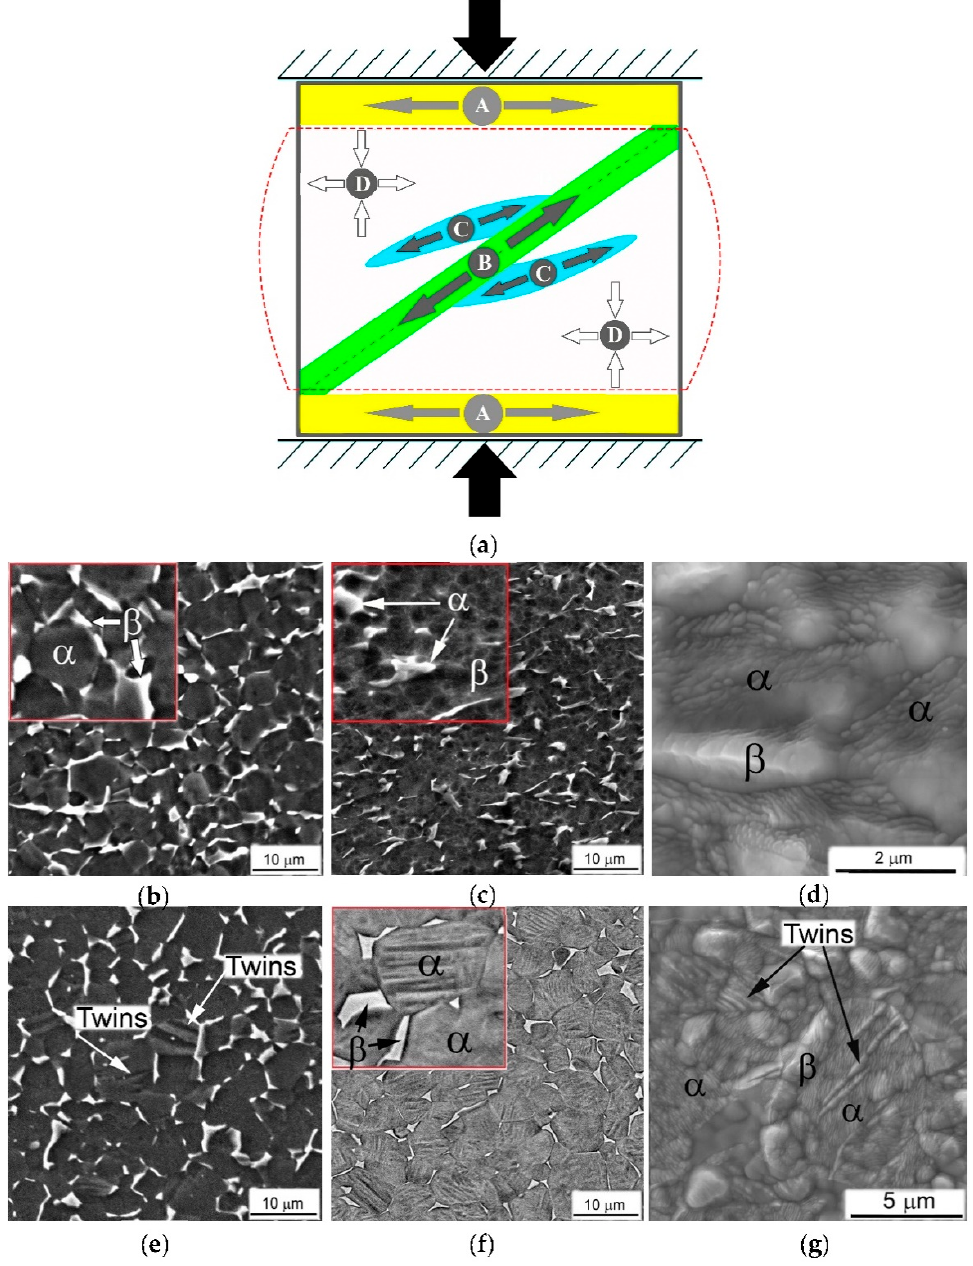
Figure 1. Schematic representation of specific zones where deformation is differently localized at macro-level shown in the longitudinal section of tested cylindrical specimen ( a )—A–D denote a specific zone; the arrows indicate the direction of the acting forces [17]; observed microstructure of Ti64 alloy in ( b ) initial state, and after ( c , d ) quasi static (strain rate 10 − 3 s − 1 ), and ( e – g ) SHPB compression with strain rates ( e ) 2100 s − 1 , ( f ) 2500 s − 1 , and 3320 ( g ) s − 1 . SEM: ( b – e , g ) SE, ( f )